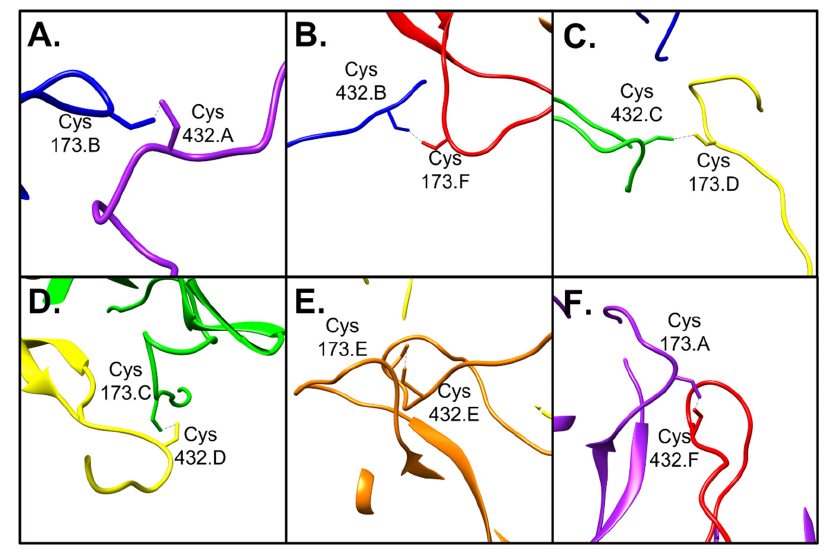
Figure 4. Disulfide bonds connect capsomers. Each copy of L1 has a connecting arm that extends to a neighboring capsomer where a disulfide bond is formed. ( A – F ) Disulfide bonds made between Cys 432 of the connecting arm, and Cys 173 of the receiving capsomer. A–F, respectively represent each connecting arm connection of chains A–F (colored as in Figures 2 and 3, purple, blue, green, yellow, orange, and red, respectively).